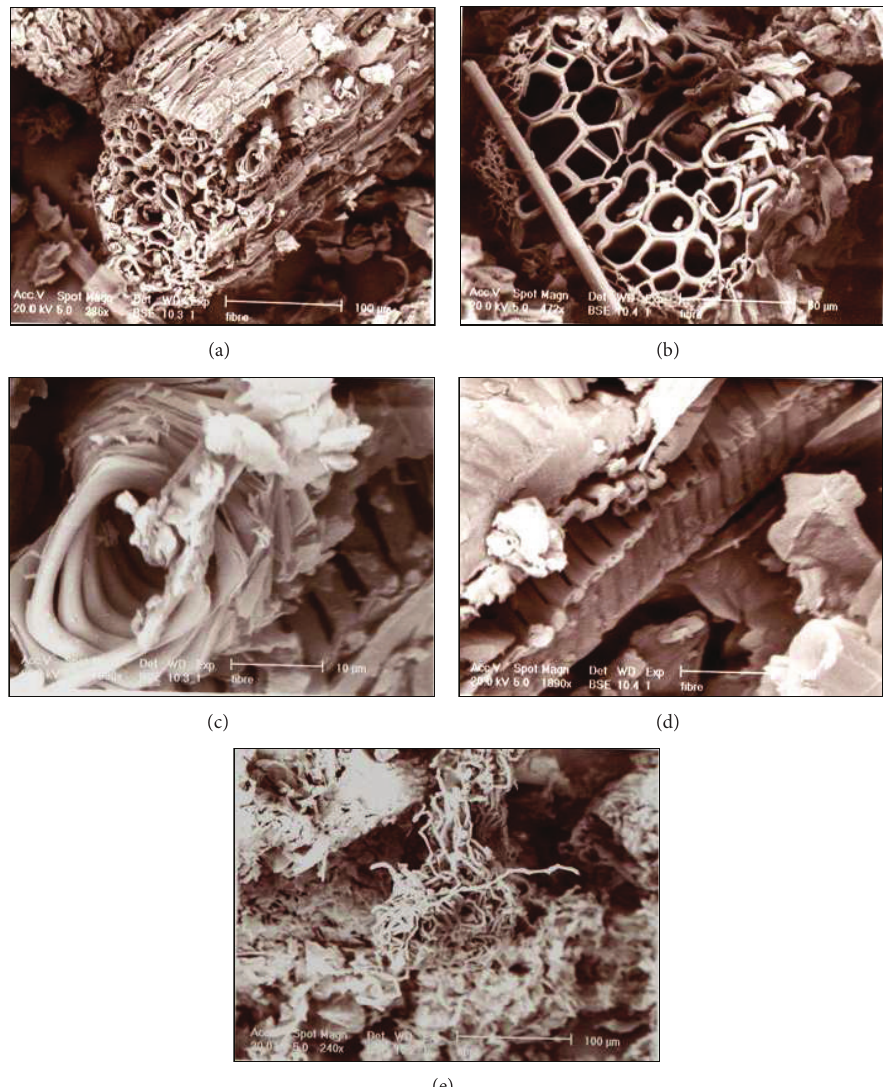
Figure 5: Scanning electron microscopy images of insoluble fibres concentrate from Agave americana L.; scale bar for (a) and (e), 100 𝜇 m; scale bar for (b), 50 𝜇 m; scale bar for (c) and (d), 10 𝜇